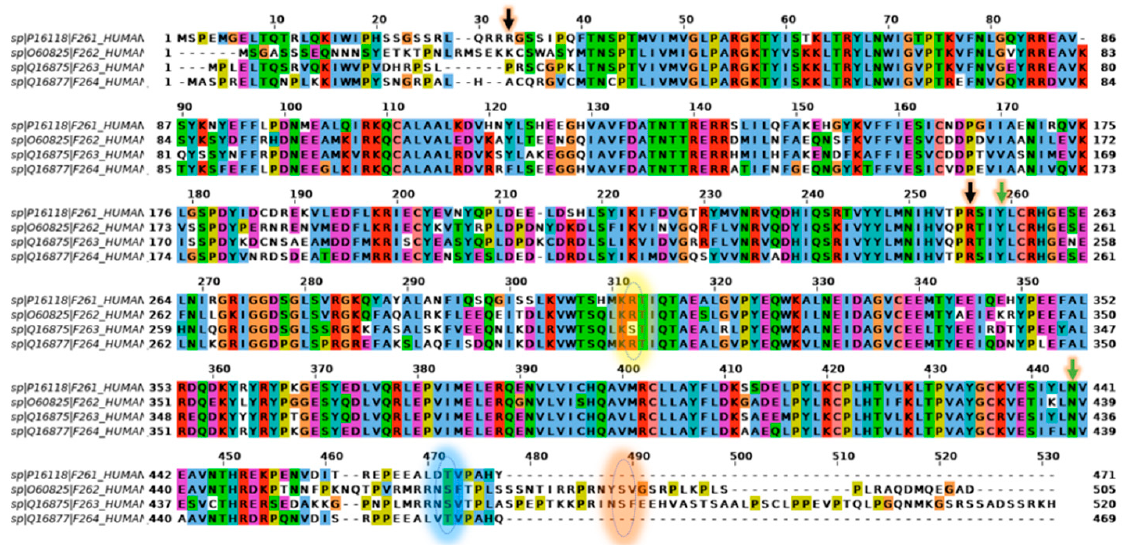
Figure 4. Multi-sequence alignment (MSA) of human PFKFB1, PFKFB2, PFKFB3, and PFKFB4. The black and green arrows with the yellow glow indicate the start and end of N-terminal (2-Kase) and C-terminal (2-Pase) domains, respectively. The yellow glowing circle near amino acid 310 indicates the position where serine 303 of PFKFB3 is located; the blue and red glowing circles indicate where serine 460 (PFKFB3), serine 466, and serine 486 (PFKFB2) are localized. The coloring shows the regions with conserved types of amino acids: blue–hydrophobic amino acids, red–amino acids with a positive charge, magenta–amino acids with a negative charge, green–polar amino acids, pink–cysteine, orange–glycines, yellow–prolines, cyan–aromatic, and white–lack of conservation. The alignment was obtained using ClustalX [41] and is based on sequences deposited in the Uniprot database [42]; the accession numbers are as follows: PFKFB1: P16118-1, PFKFB2: O60825-1, PFKFB3: Q16875-1, PFKFB4: Q16877-1. The figure was prepared using the JalView software